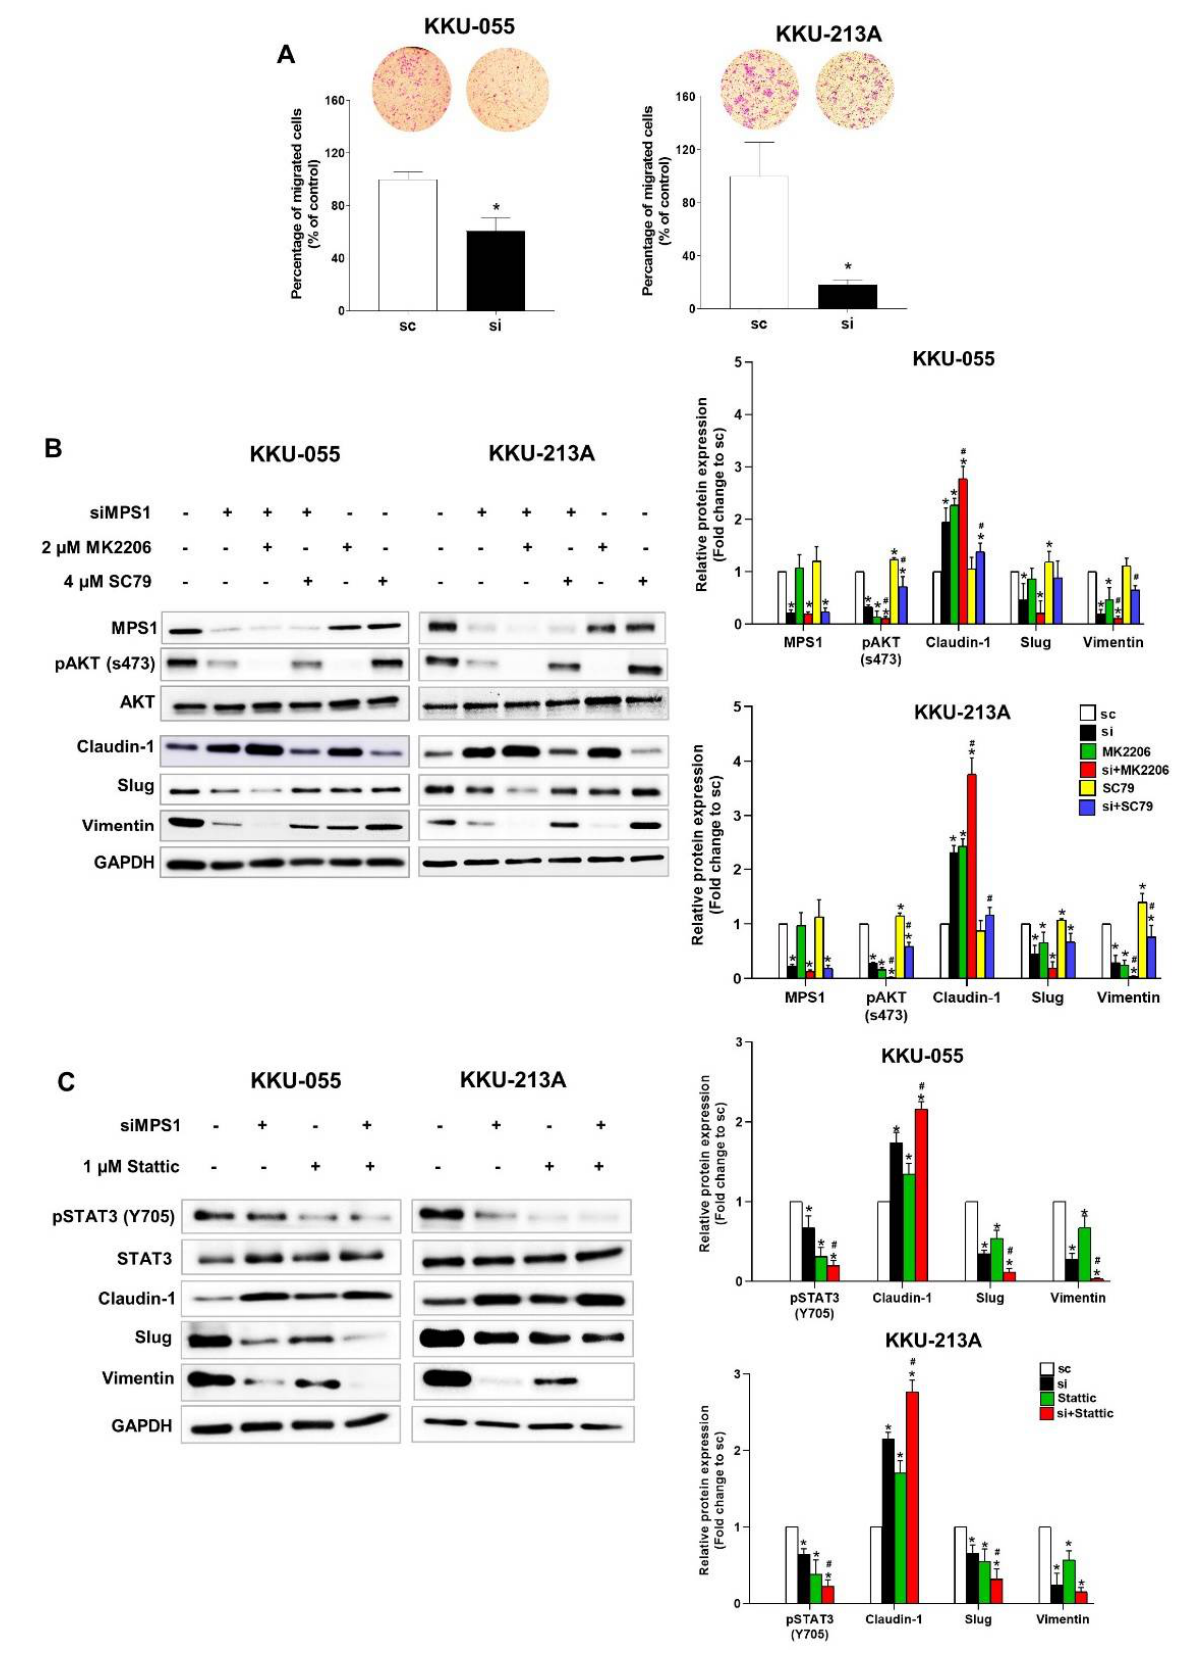
Figure 4. MPS1 promoted EMT-mediated migration via AKT and STAT3 signaling pathways. ( A ) Boyden chamber assay was performed to evaluate the migration of siMPS1 treated KKU-055 and KKU-213A cells. ( B ) Cells were pre-treated with siMPS1 and an AKT inhibitor (MK2206) or an AKT activator (SC79). The expression of EMT-related proteins was analyzed using Western blot assay. Representative results of claudin-1, slug, vimentin, pAKT (s473), and pSTAT3 (Y705) are shown. GAPDH was used as an internal control. Quantification of protein expression was normalized with GAPDH and by as- signing the scramble (sc) control as 1. Bar graph shows the mean ± SD band intensities of proteins from three independent experiments. ( C ) Combination of siMPS1 and a STAT3. inhibitor (Stattic) greatly altered the expression of EMT-related markers in KKU-055 and KKU-213A cell lines. Protein loading and protein quantification were performed as described for Figure 4B. Significant difference ( p < 0.05) when compared with sc (*) or si ( # ). Matrigel coated transwell inserts were used to study the invasive ability of MPS1 knockdown cells. MPS1 suppression significantly decreased the invasion of KKU-055 and